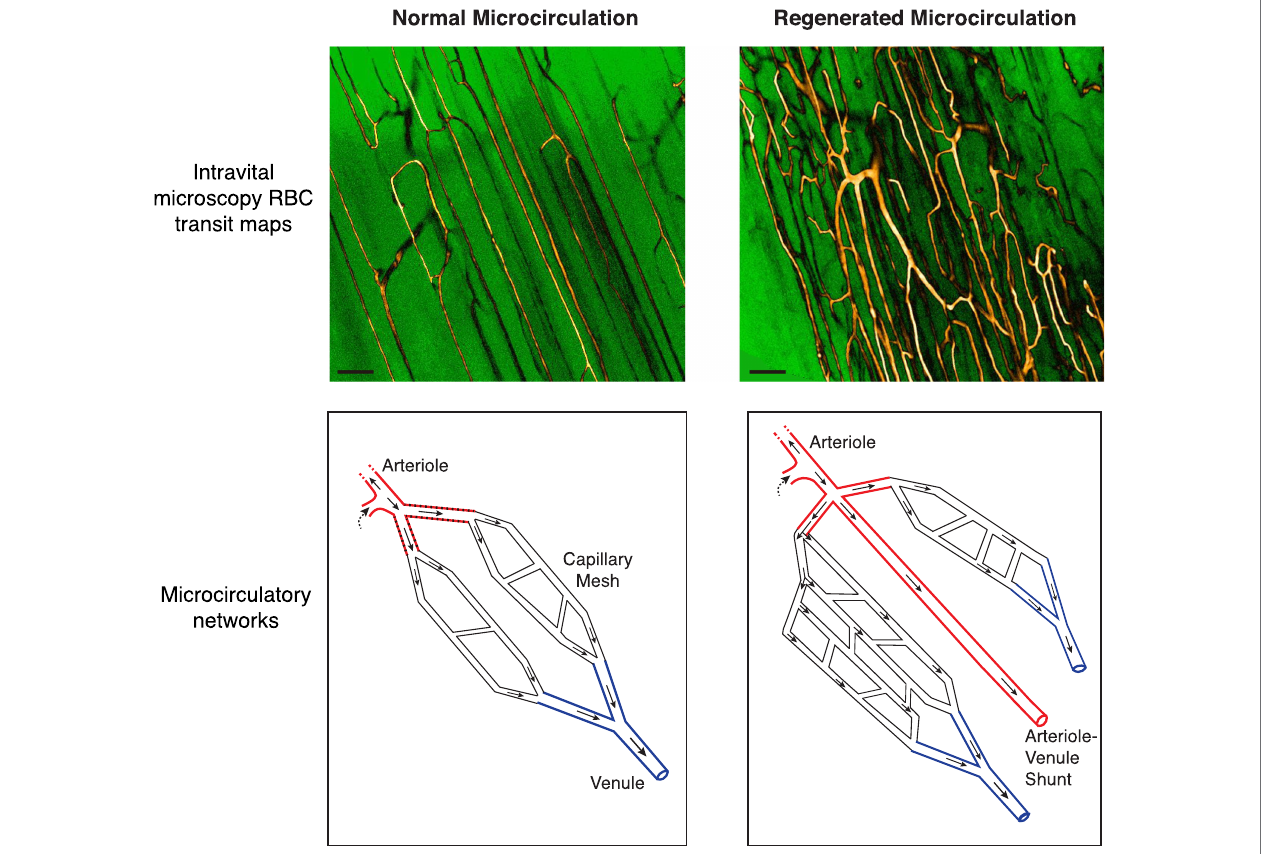
FIGURE 1 | Abnormalities in the regenerated microvascular network in the mouse subjected to ischemic injury. (Top) Intravital microscopy-derived RBC transit maps of the extensor digitorum longus muscle in a C57BL/6 mouse. Maps depict all flow-receiving surface (50 μ m deep) vessels over a 15 s period. Custom look- up tables were applied to grayscale image maps for enhanced contrast. A native network is shown in the left panel. Capillaries are running parallel to the skeletal myofibers with ordered anastomoses between parallel capillary segments. A regenerated network 28 days after ischemic injury is shown in the right panel, showing increased and chaotic vascularity. Bar, 100 μ m (Bottom) Schematics of native and regenerated (day 28) microcirculatory networks. In the regenerated network the distal arteriole trifurcates. Moreover, one of the three limbs drains directly into a venule rather than branching into a capillary meshwork [See Arpino et al. (2017) for RBC transit maps and videos demonstrating these